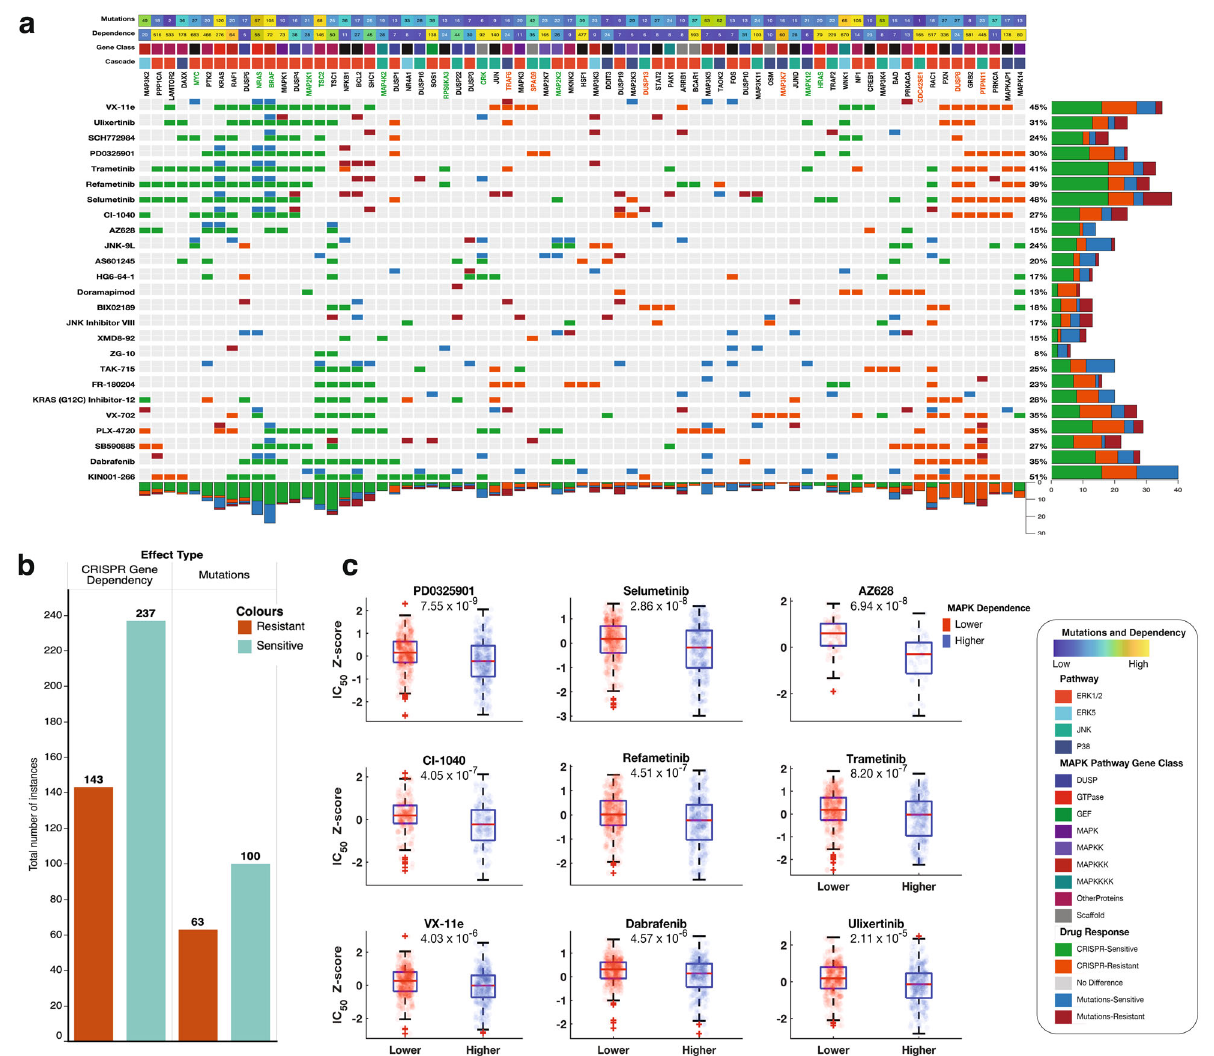
Fig. 6 Relationship between Achille gene dependence scores or mutations of MAPK pathway genes and the responses of the cell line to MAPK pathway inhibitors. a The integrated plot is showing the relationship between gene dependencies or mutations and drug responses across cancer cell lines. From top to bottom panels indicate: the overall mutation frequencies observed for the gene along that column. Dependence; the overall CRISPR-derived gene dependence scores of the gene along that column. Gene Class; the class of the MAPK pathway protein encoded by the gene. Pathway Module; the MAPK pathway module in which the gene participates. Clustered heatmap; The marks on the heatmap are coloured based on how a high dependence on, or mutations in, the gene along each column affect the ef fi cacy of the drug given along each row: (1) with green (for gene dependence) and blue (for gene mutations) denoting signi fi cantly (10% false discovery rate) increased sensitivity, (2) grey for no statistically signi fi cant difference between cell line with a higher and lower dependence on the gene, and (3) orange (for gene dependence) and deep red (for gene mutations) denoting signi fi cantly increased resistance. The gene names (column labels) are coloured based on the overall calculated effect that high dependence on the gene has on the ef fi cacy of the drug given along rows. Green; all the cell lines are signi fi cantly more sensitive to all the MAPK pathway inhibitors, orange; all the cell lines are signi fi cantly more resistant to all the MAPK pathway inhibitors, and black; a mixed response to MAPK pathway inhibitors. The bar graphs represent the total numbers of drugs whose dose-response are signi fi cantly increased (green/blue) or decreased (orange/deep red). b The total number of instances (from the heatmap) for which cell lines are either signi fi cantly more resistant or more sensitive to MAPK pathway inhibitors broken down into the effect types (i.e., CRISPR dependency scores or gene mutations). c Comparison of the dose-response pro fi les to MAPK inhibitors between the cancer types with higher dependence (boxplots with blue scatter point) on MAPK signalling and those with lower dependence (boxplots with red scatter point) on MAPK signalling. The cancer types that have either a higher or lower dependency on MAPK signalling are given Supplementary File 4. Boxplots show the logarithm transformed mean IC50 values of the cancer cell lines of each group. On each box, the central red mark indicates the median, and the bottom edge represents the 25th percentiles, whereas the top edge of the box represents 75th percentiles. The whiskers extend to the most extreme data points not considered outliers, and the outliers are plotted individually using the ‘ + ‘ symbol. The scatter point within each box plot shows the overall distribution of the data